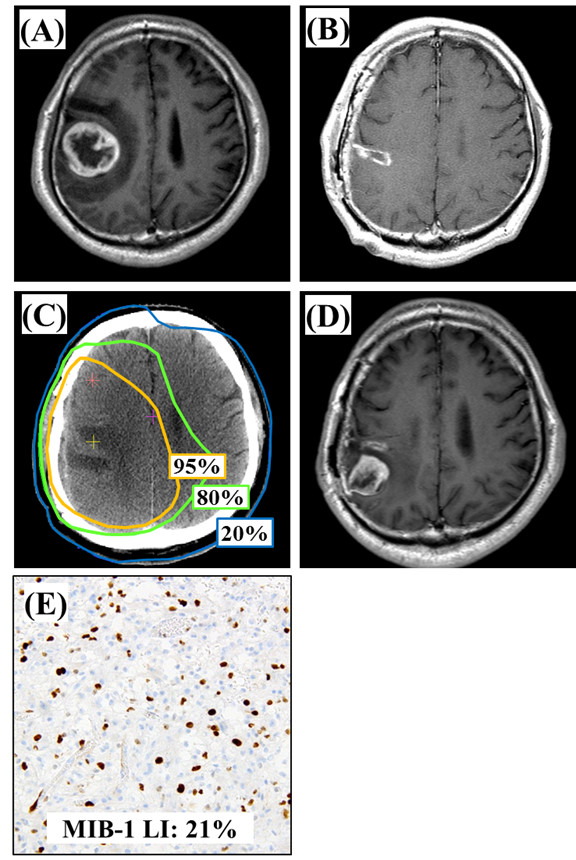
Representative images for the case of GB with lower MIB-1 LI. A 76-years
female patient with GB showing a lower MIB-1 LI (21%) that recurred in the
central region. (A) A postcontrast MR image (T1 weighted) before
surgery. (B) A postcontrast MR image (T1 weighted) after a gross total
removal. (C) Treatment planning CT image showing the 95% isodose curve
(yellow), the 80% isodose curve (green), and the 20% isodose curve (blue).
(D) A postcontrast MR image (T1 weighted) at 4 months after
completing radiotherapy showing a recurrence tumor that developed in the
central. (E) Immunohistochemical analyses (×200).